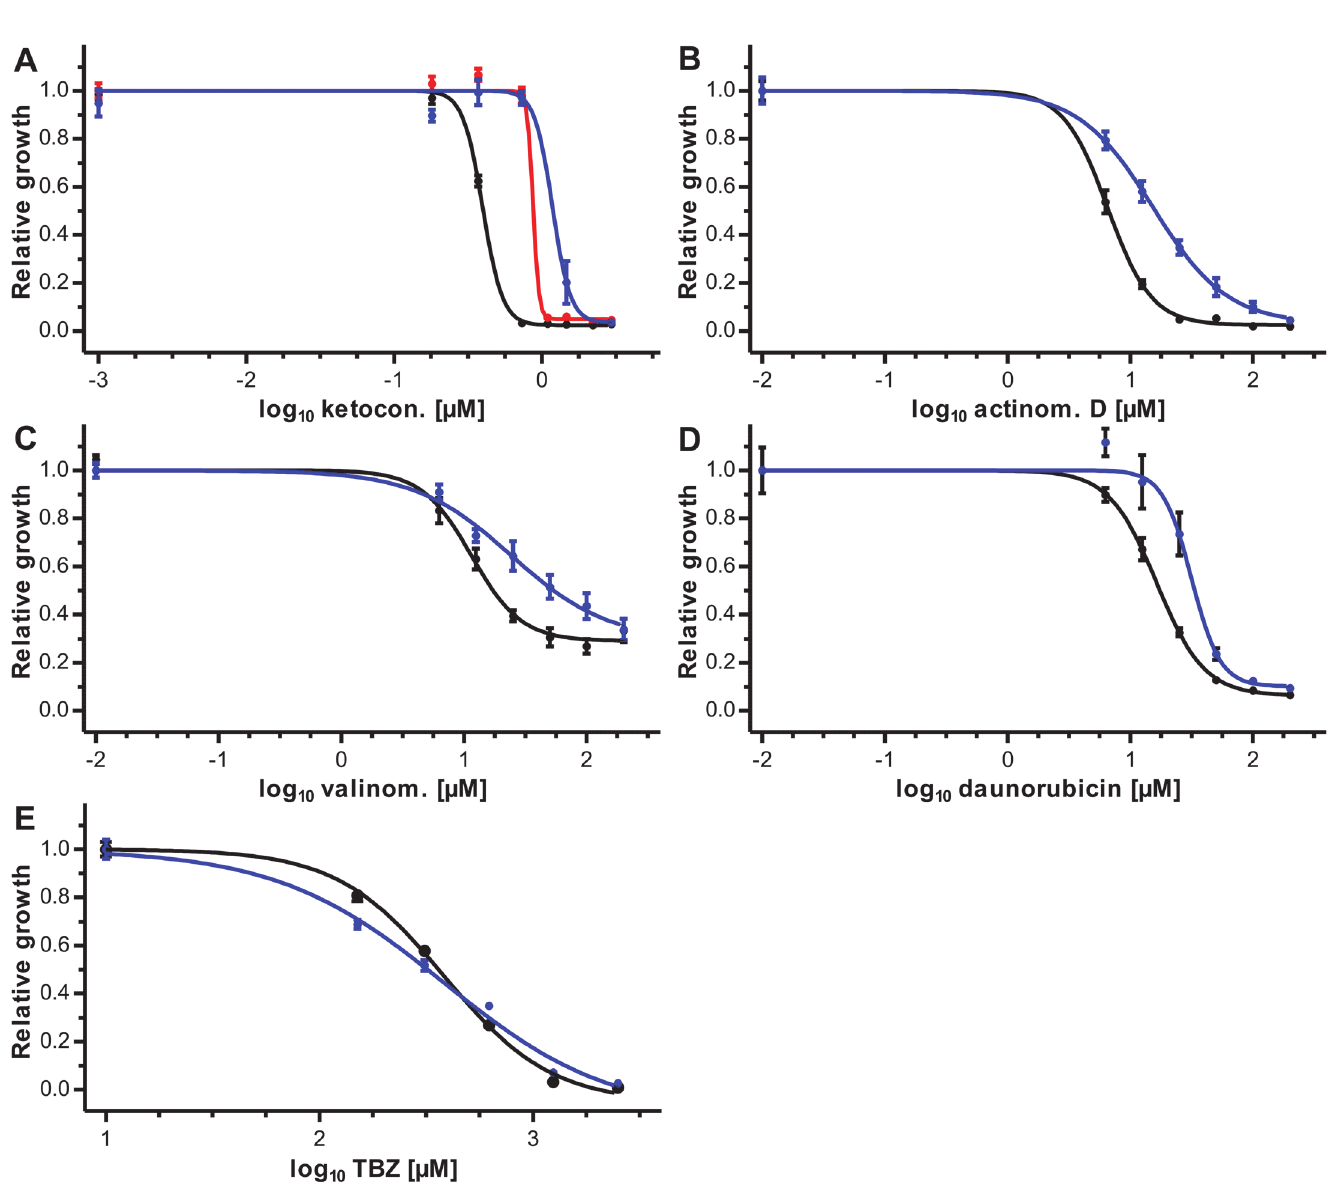
Fig 3. Effects of Ceg Pgp-9 expression on toxicity of directly fungicidal potential Pgp substrates. Effects of ketoconazole (A), actinomycin D (B), valinomycin (C), daunorubicin (D), and thiabendazole (E) were compared between the control yeast strain AD1-7 expressing lacZ (black) and AD1-7 strains expressing Ceg Pgp-9 either without tag (red) or with a V5/6×His tag (blue). Concentration response curves were recorded by measuring the OD 600 every 10 min for 48 h. Data were retrieved from 18 data points per concentration (three plates each with six replicates) and normalized to the mean of the no drug control for the same strain (= relative growth). Mean relative growth ( ± SEM) were plotted against log 10 of drug concentrations. Four parameter logistic regression curves were calculated and, due to the normalization, the upper asymptote was constrained to 1.